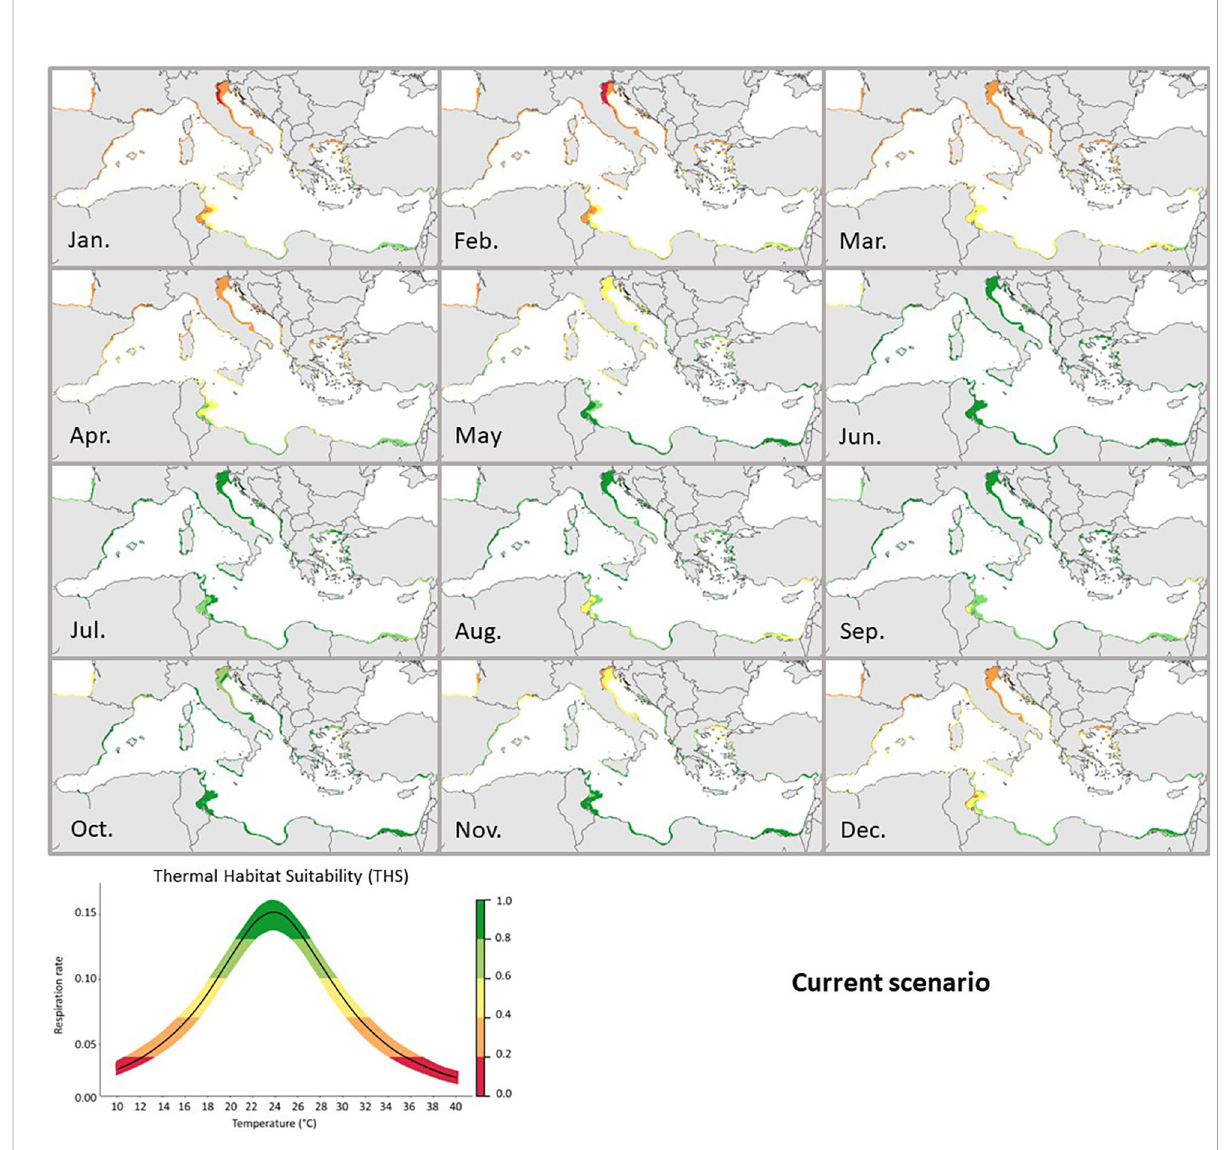
FIGURE 4 Current predicted Thermal Habitat Suitability (THS) of Callinectes sapidus in the Mediterranean Sea. The graph below represents the Thermal habitat suitability (THS) scale within the TPC of Callinectes sapidus ranging from low (0) to high (1) species thermal suitability probability. Different colors (representing the THS scale) would correspond to: optimum temperature range (green colored), lower and upper pejus ranges (light green and yellow colored), pessimum (orange colored), and lethal ranges (red